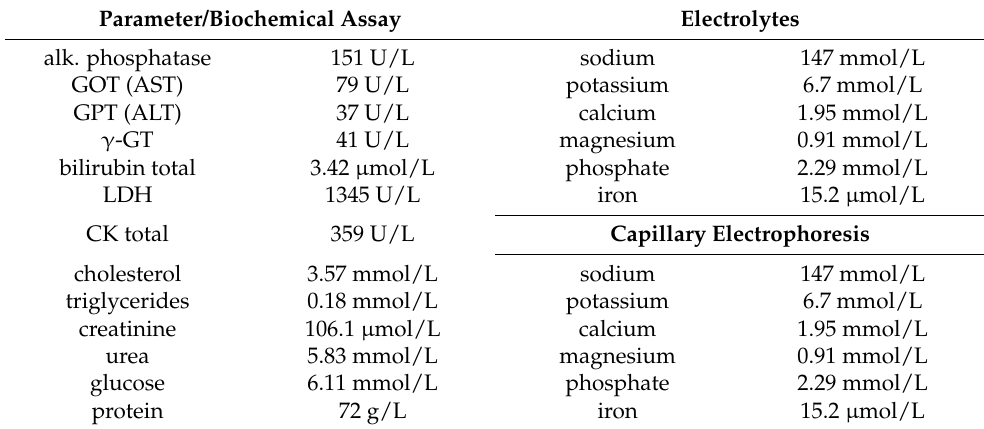
Figure 1. Photograph of the pin-on-disk tribometer inside the climatic chamber ( a ) and schematic representation of the experimental setup ( b ). Table 2. BCS composition as specified by the supplier